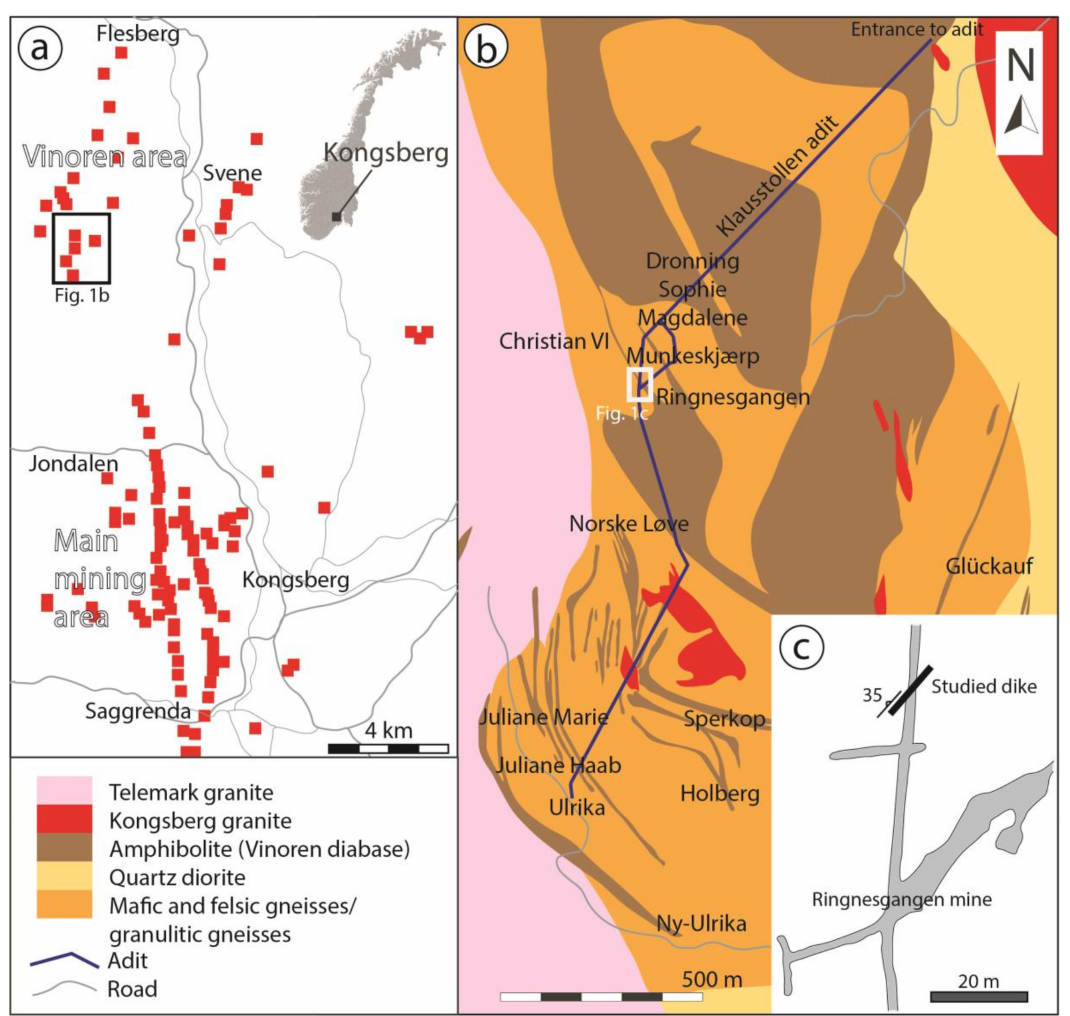
Figure 1. ( a ) Overview map showing the occurrences of silver mines in the Kongsberg silver district. Black rectangle shows location of (b). ( b ) Simplified geological map of the central part of the Vinoren area. White rectangle shows the location of (c). ( c ) Sketch showing the occurrence of the studied dyke in the Klausstollen adit, adjacent to the Ringnesgangen underground silver